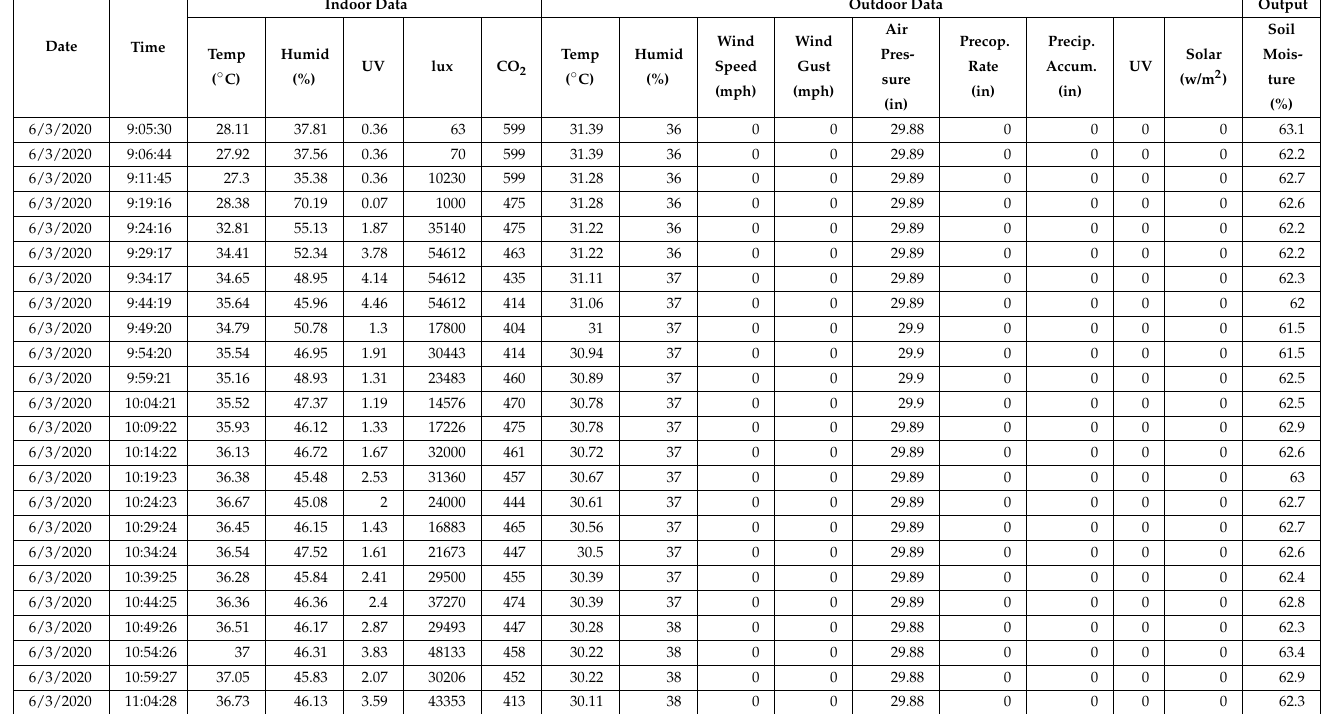
Table 2. Sample of the collected raw